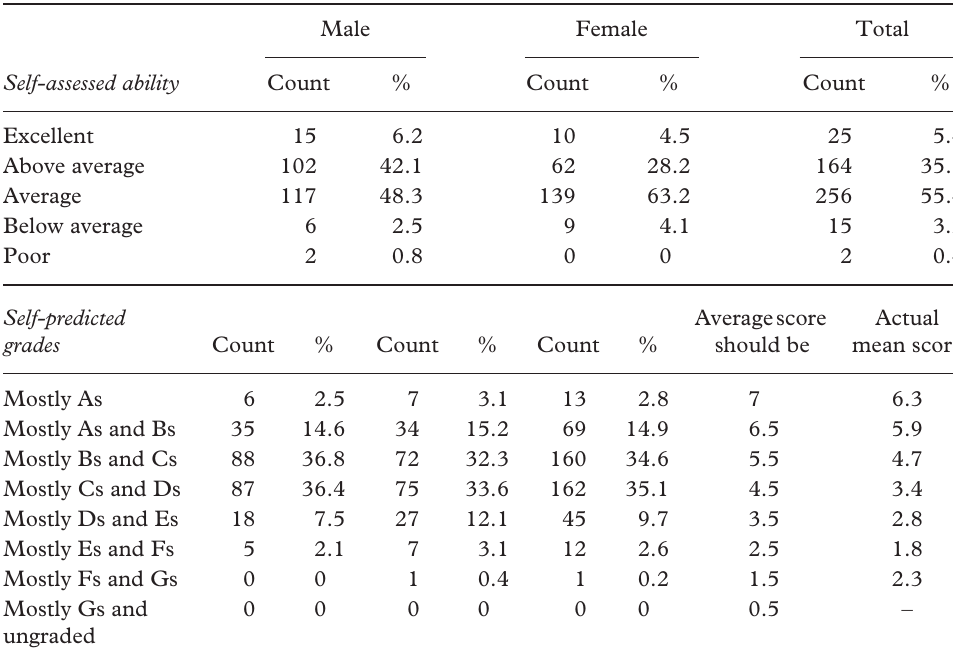
Table 3. Pupils’ self-assessed ability and self-predicted